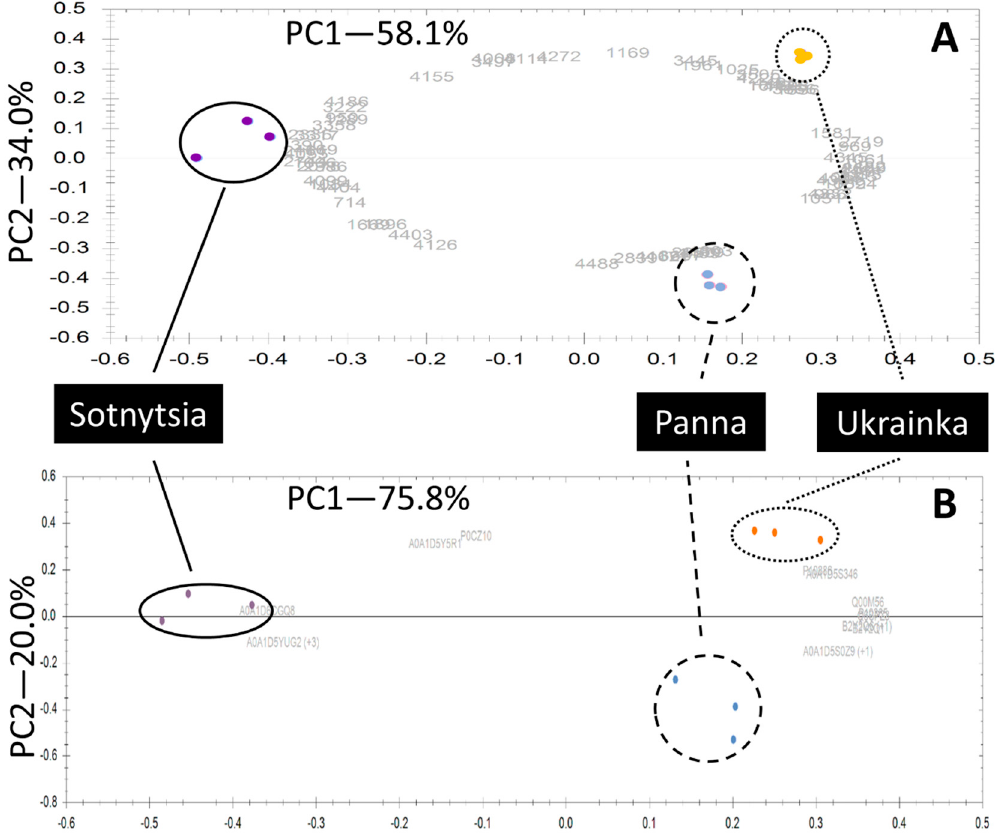
Figure 2. Principal component analysis of differentially abundant proteins showed excellent reproducibility among biological replicates for both analytical approaches and suggested that modern cultivar Sotnytsia is distant: ( A ) 66 gel spots; ( B ) 12 proteins discovered upon direct mass spectrometry quantification. Multidimensional statistics were calculated and visualized using functions integrated into SameSpots 5.1 and Progenesis QI.